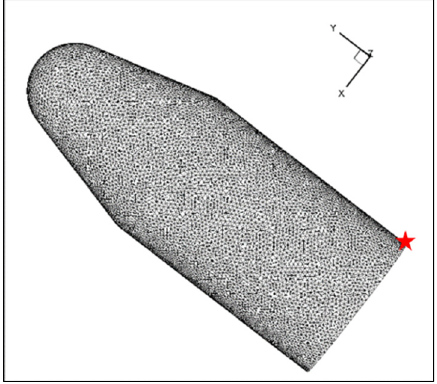
Figure 4. Structural grid and monitoring point (red star).